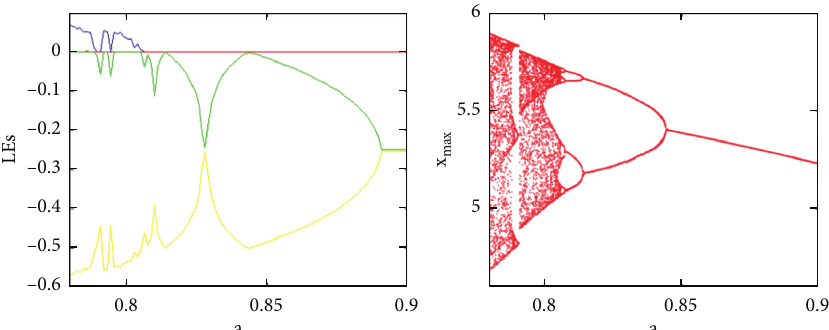
Figure 4: Lyapunov exponent spectrum and bifurcation diagram of system (1) with (b) � 0.5, (c) � 1, (d) � 0.1 and initial condition IC � (0.01, 0.01, 0, 0), when (a) varies in [0.78, 0.9].